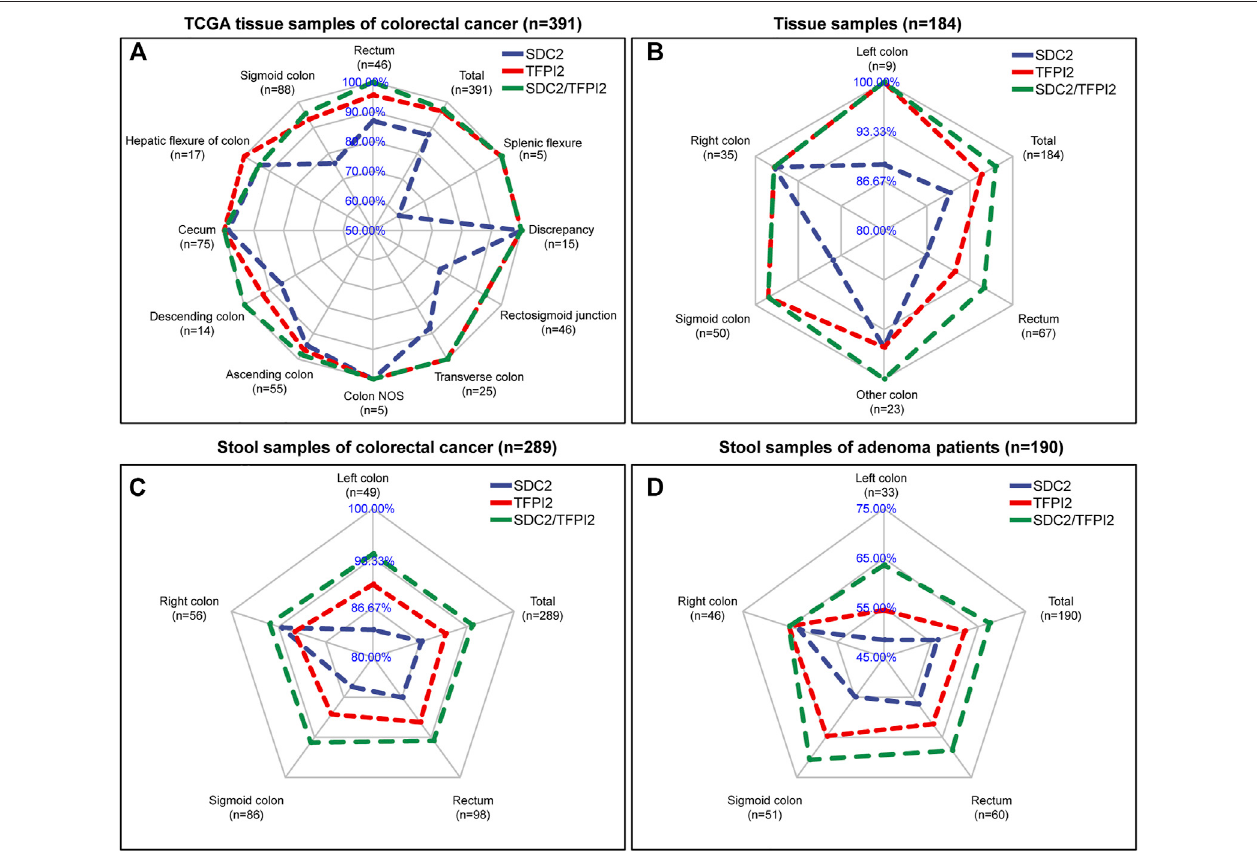
FIGURE 4 | Comparison of the sensitivity of SDC2 , TFPI2 , and SDC2 / TFPI2 in detecting colorectal cancer of various locations. The blue line is related to the detectionsensitivityof SDC2 ,theredlinetothatof TFPI2 ,andthegreenlinetothatof SDC2 / TFPI2 incombination.Thecutoffvalueis β (cid:1) 0.2for (A) andCt (cid:1) 38for (B – D) . (A) shows detection sensitivity based on β values generated by a 450k methylation chip in TCGA tissue specimens (n (cid:1) 391 cancer and 45 normal samples). (B) shows detection sensitivity based on Ct values generated by methylation-speci fi c PCR of the tissue specimens (n (cid:1) 184) collected in this study. (C) shows detection sensitivity based on Ct values generated by methylation-speci fi c PCR of stool specimens (n (cid:1) 289) of patients with colorectal cancer collected in this study. (D) shows detection sensitivity based on Ct values generated by methylation-speci fi c PCR of stool specimens (n (cid:1) 190) of patients with colorectal adenomacollected in this study.